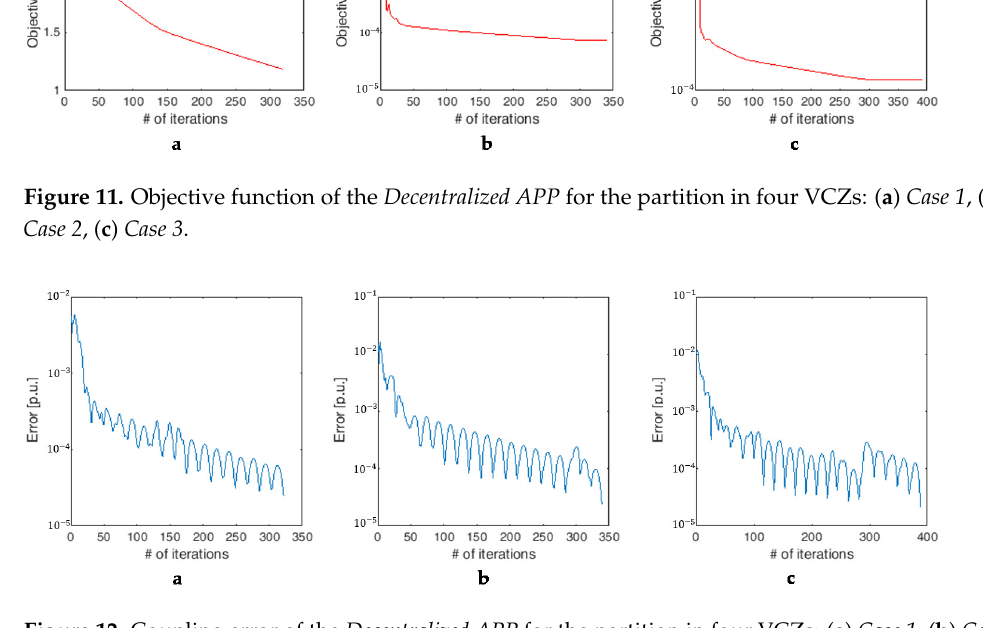
Figure 12. Coupling error of the Decentralized APP for the partition in four VCZs: ( a ) Case 1 , ( b ) Case 2 , ( c ) Case 3